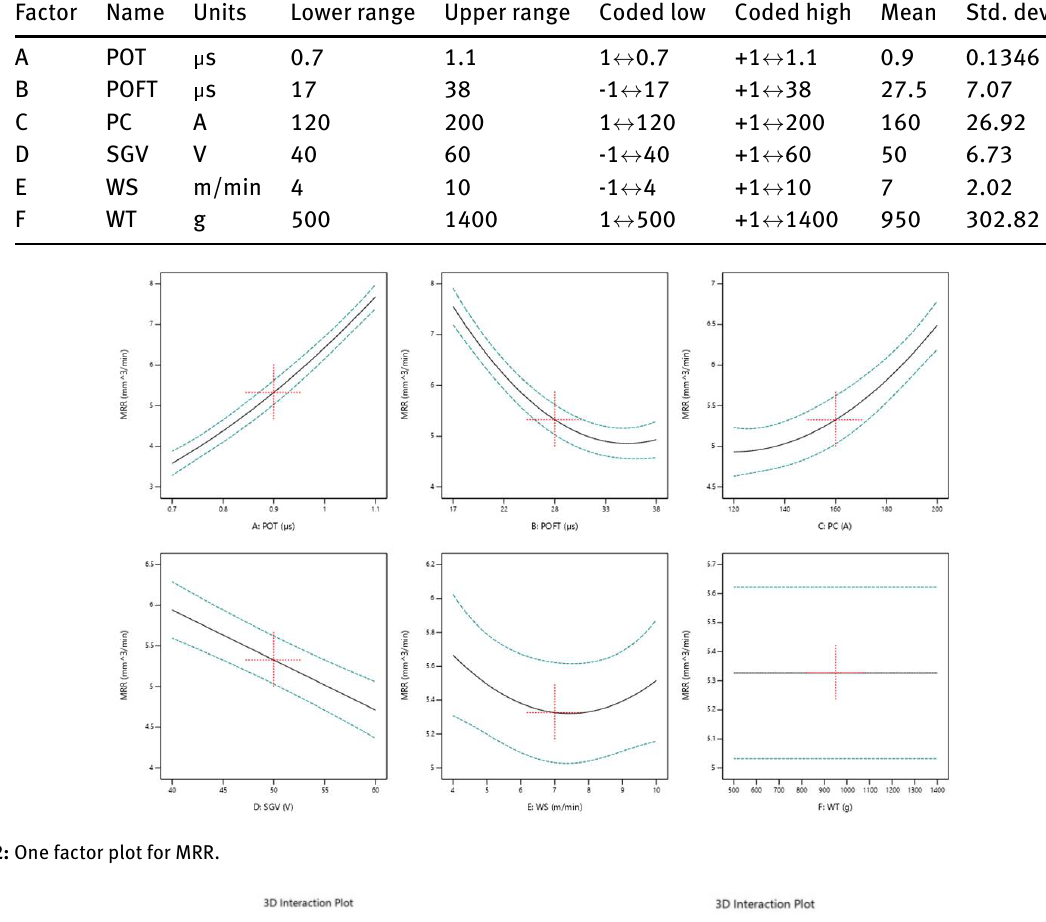
Figure 2: One factor plot for MRR.